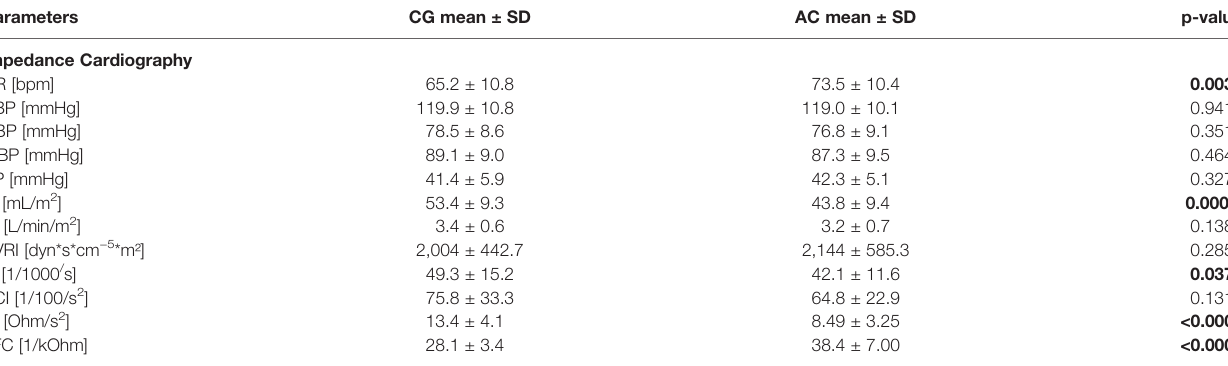
TABLE 4 | Comparison of the control group (CG) and the acromegaly (AC) group in terms of the hemodynamic parameters assessed via impedance cardiography.